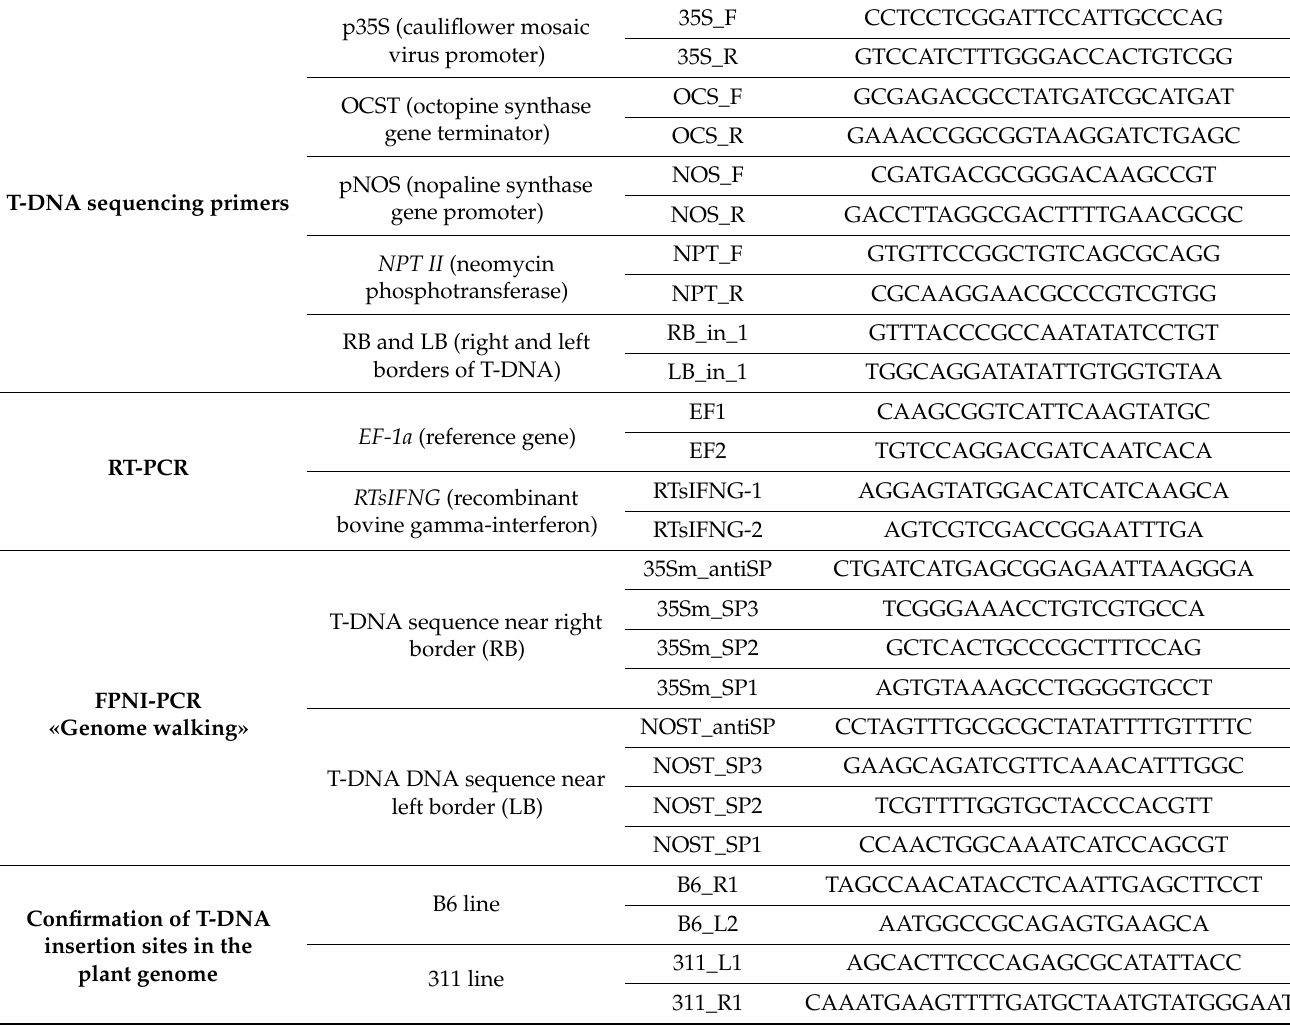
Table 1. Primers used in the